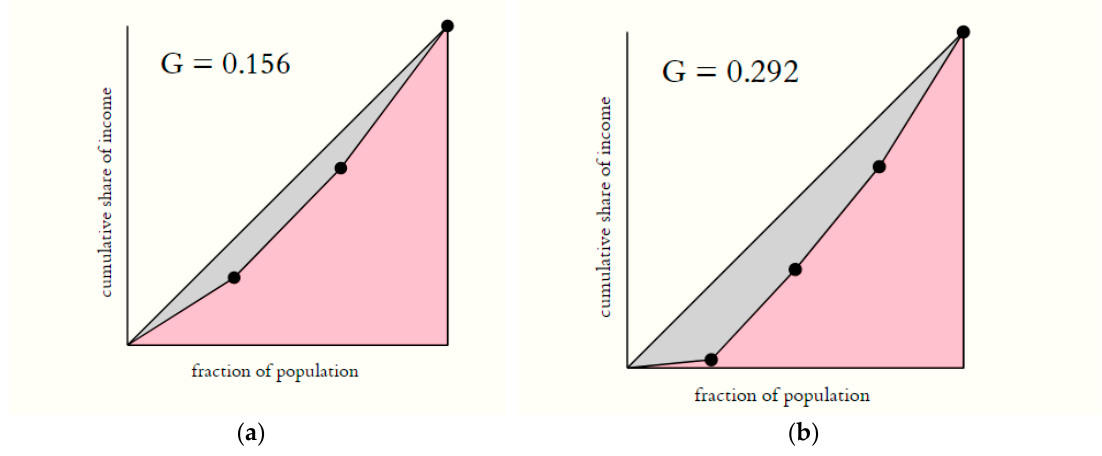
Table 4. Values of coefficient of variance in period 2013–2017.